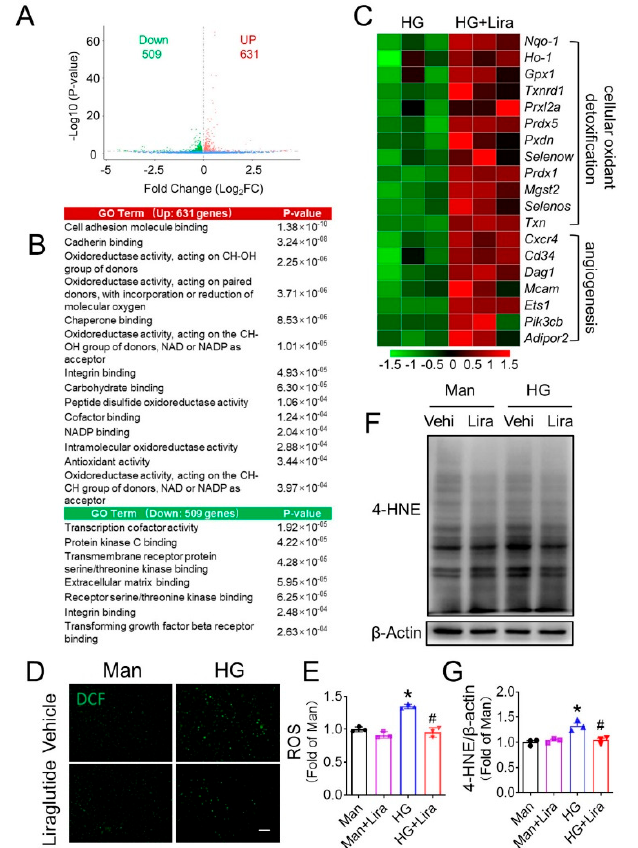
Figure 4. Liraglutide ameliorates oxidative stress in HG-treated EPC. EPC were treated with HG or HG plus liraglutide (HG + Lira) for 24 h, and total RNA was isolated and analyzed by RNAseq (n = 3 per group). Genome-wide changes in mRNA expression shown in a volcano plot, and the numbers refer to the number of genes up- or down-regulated by two-fold or more with a p value < 0.05 ( A ). GO enrichment analysis indicates the biological pathways and molecular functions that is significantly different between HG + Lira group and HG group ( B ). The selected genes with differential expression between HG and HG + Lira group are listed in heatmap ( C ). Oxidative stress in EPC treated with Man or HG in the present or absent of liraglutide were indicated by DCF staining ( D , E ), and oxidative stress marker 4-HNE was detected by Western blot ( F , G ). Data shown in graphs represent as mean ± S.D. * p < 0.05 vs. Man group; # p < 0.05 vs. HG group. Bar = 100 µm.